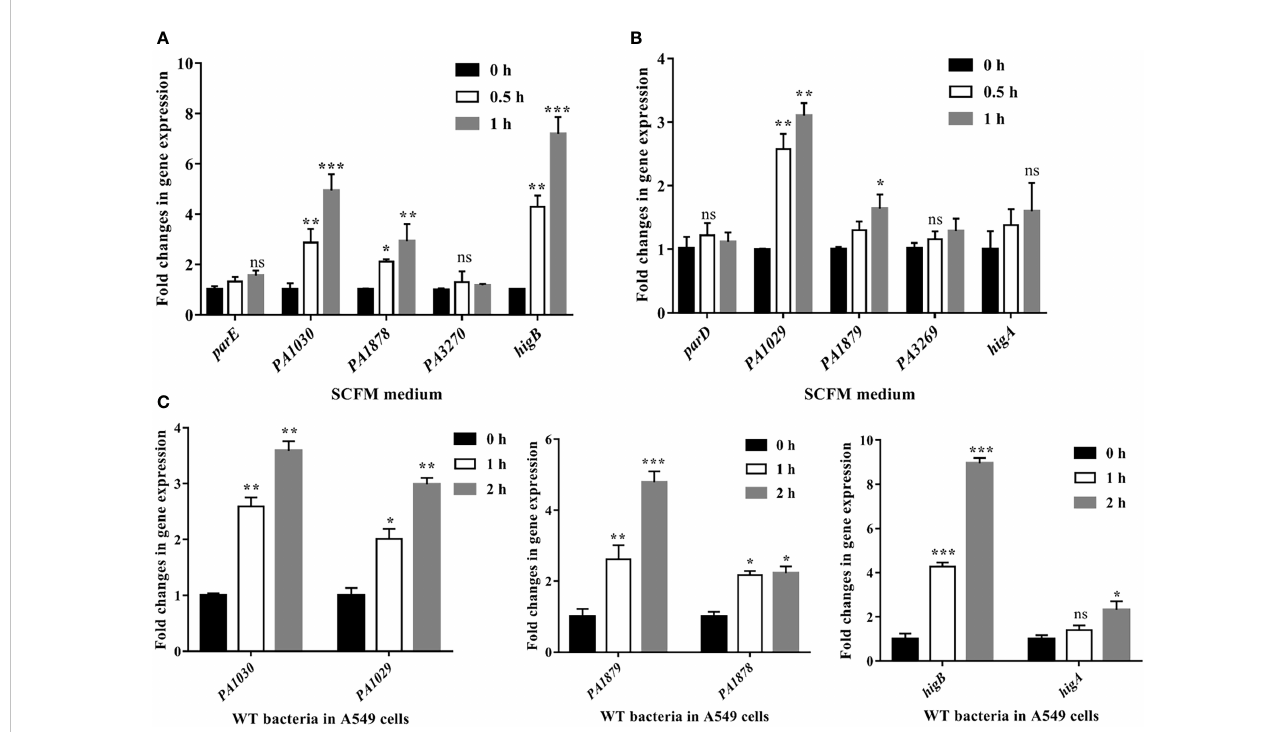
FIGURE 5 The PA1030 , PA1878 and higB are activated in SCFM medium and cell adhesion process. Relative mRNA levels of toxins (A) and antitoxins (B) in SCFM. Overnight bacterial cultures of WT P. aeruginosa grown in LB medium were re-inoculated into fresh SCFM at OD 600 = 0.5 for next culture at 37°C for 0.5 or 1 h. Then the bacteria cultures were collected and the bacterial RNA was extracted for qRT-PCR assays. (C) Relative gene expression levels of PA1030 , PA1878 , higB and their cognate antitoxins in bacterial infection upon A549 cells. The A549 cells were seeded in a 6-well tissue culture plate and then were infected with P. aeruginosa PA14 at an MOI of 100 for 1 and 2 h, respectively. The A549 cells were treated with 1% Triton X-100 for 15 min, washed with PBS twice, and then treated with DNase for another 15 min. The bacteria were collected for RNA isolation and qRT-PCR. * p < 0.05; ** p